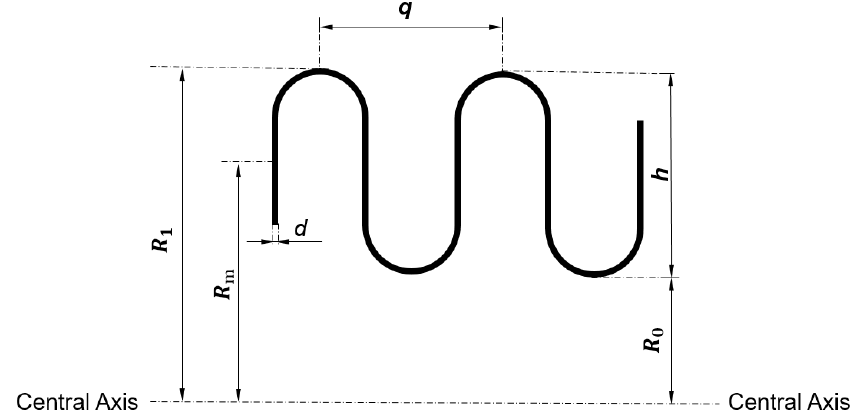
Figure 3. Cross-section of U-shaped bellows. Table 1. Structural and material parameters of the standard bellows. Structural Parameters (mm)